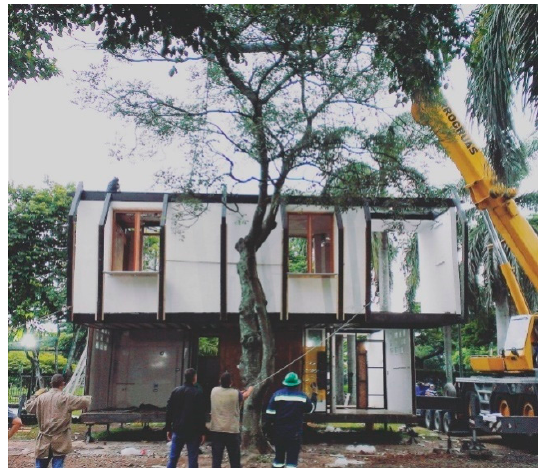
Figure 1. Image of the prototype assembly process.